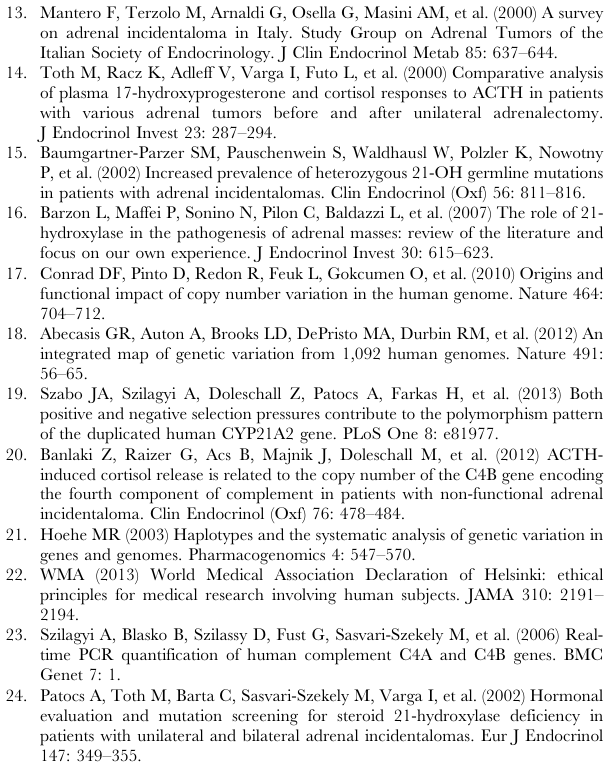
significances (p , 0.05) and high power (power . 0.8) are highlight- ed with bold characters. Table S3 Relationship between hormone levels and the frequent genotypes of site 398 and site 568 in subjects with non-functional adrenal incidentaloma. ACTH – adrenocorticotrophic hormone. CC genotype of site 398 (N = 4) and 2 / 2 genotype of site 568 (N= 1) did not exceed 4 group members, hence they were not taken into account. The normalities of hormone datasets were checked by the Kolmo- gorov-Smirnov (K-S) test, and the datasets passing the normality test were investigated with the t-test, whereas the datasets not passing the K-S test were examined by the Mann-Whitney test. Median values are represented, interquartile ranges are shown in parentheses below the median values, ns; non-significant result, significant hormone levels (p , 0.05) with high power (power . 0.8) are highlighted with bold